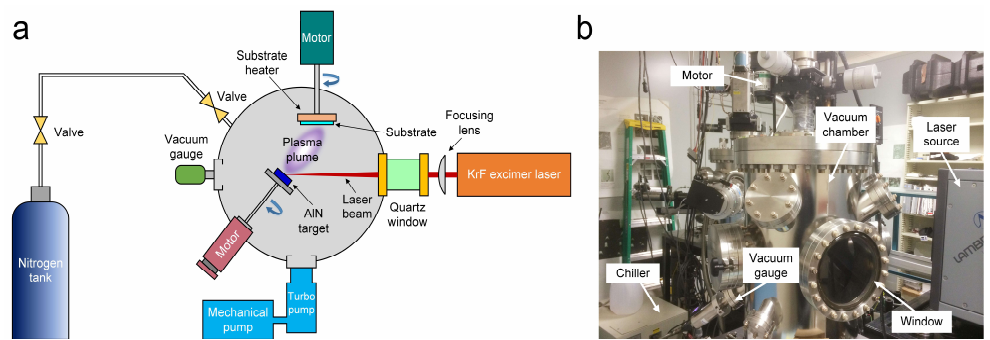
Figure 2. ( a ) Schematic illustration and ( b ) photography of the growth process of AlN thin film by PLD.